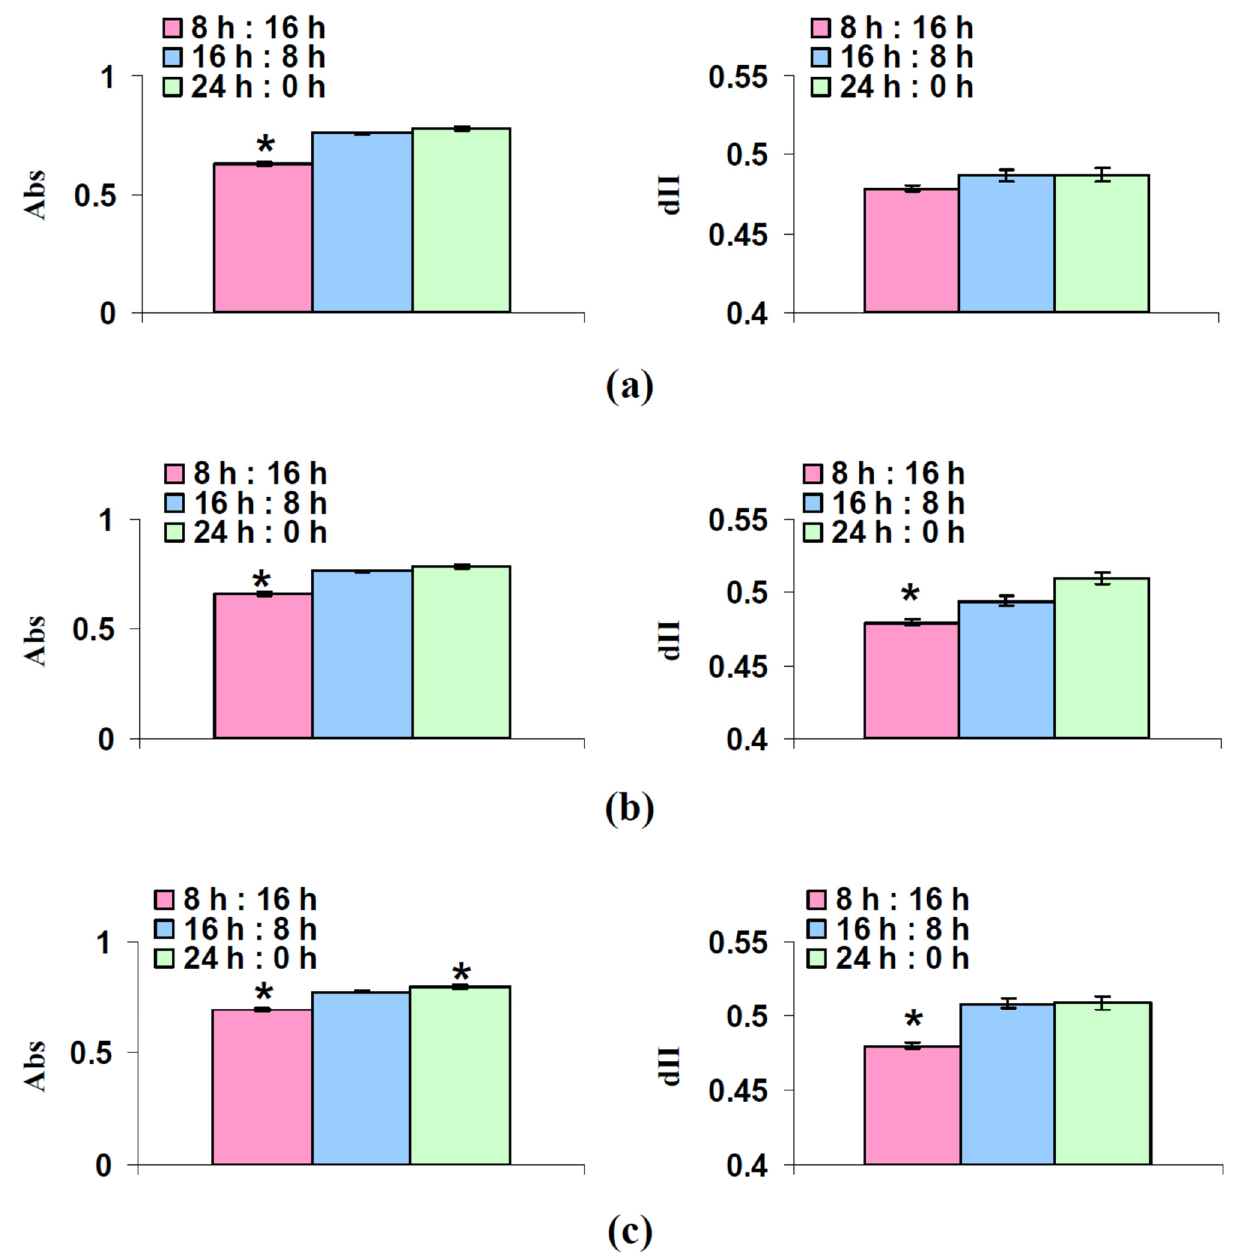
Figure 4. Fraction of the actinic light absorbed by the leaf (Abs) and fraction of the absorbed light distributed to photosystem II (dII) after 18 days ( a ), 25 days ( b ), and 32 days ( c ) of lettuce cultivation ( n = 6). “8 h:16 h” is 8 h (light):16 h (dark), “16 h:8 h” is 16 h (light):8 h (dark), and “24 h:0 h” is 24 h (light):0 h (dark). *, difference from control plants cultivated under 16 h (light):8 h (dark) were significant ( p < 0.05).